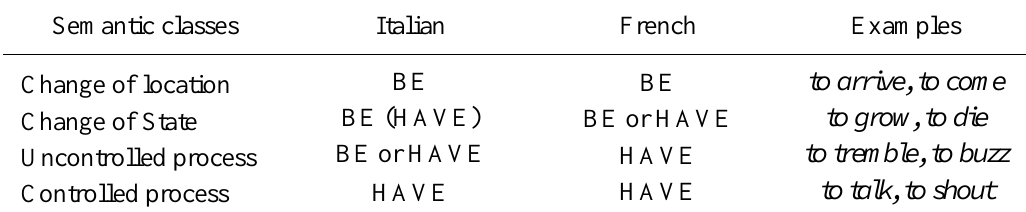
Table 5 . The UH in Italian and French (adapted from Sorace & Legendre, 2003) Semantic